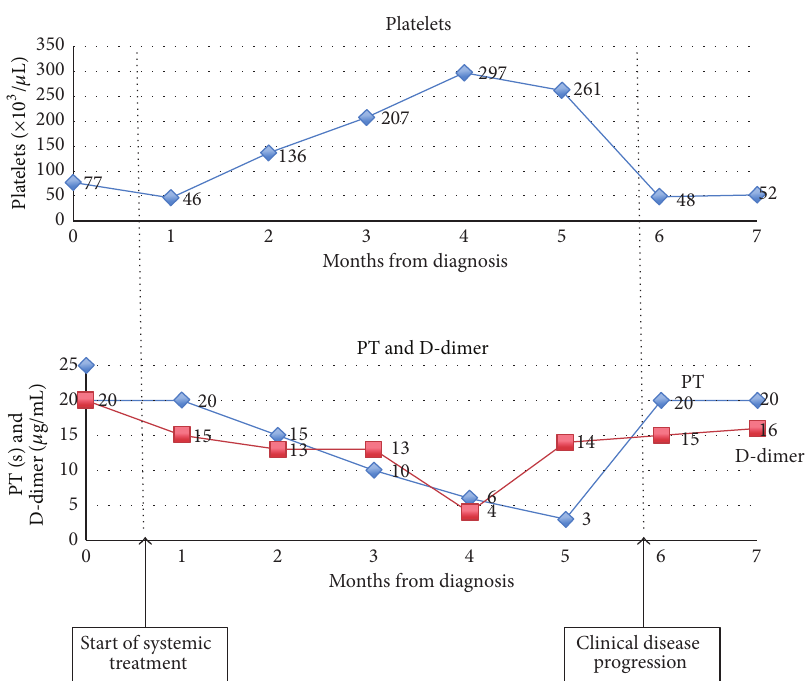
Figure 2: Variation in hematological and coagulation parameters showing coagulopathy at diagnosis that improved with therapy but recurred at disease